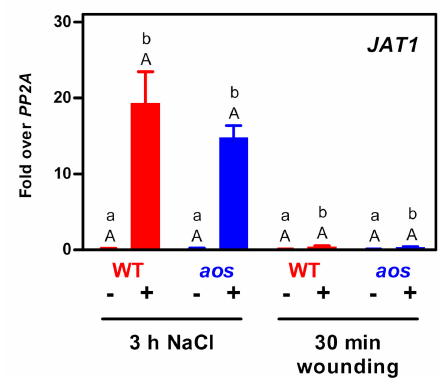
Figure 4. Quantitative RT-PCR analysis of JAT1 transcript levels in RNA collected from root material of wild-type and aos plants under control conditions ( − ), upon NaCl treatment for three hours ( + ) or after wounding with subsequent incubation for 30 minutes in hydroponic solution ( + ). Relative transcript levels were determined using PP2A as a reference gene. Data are mean values ± SEM of three to four samples, each representing pooled root tissue from two individual plants. Statistical analysis was performed for the di ff erent inductions separately using a two-way ANOVA followed by Bonferroni’s post-test: uppercase letters indicate significant di ff erences ( p < 0.05) between genotypes subjected to the same treatment; lowercase letters indicate significant di ff erences ( p < 0.05) between control and treatment performed with the same